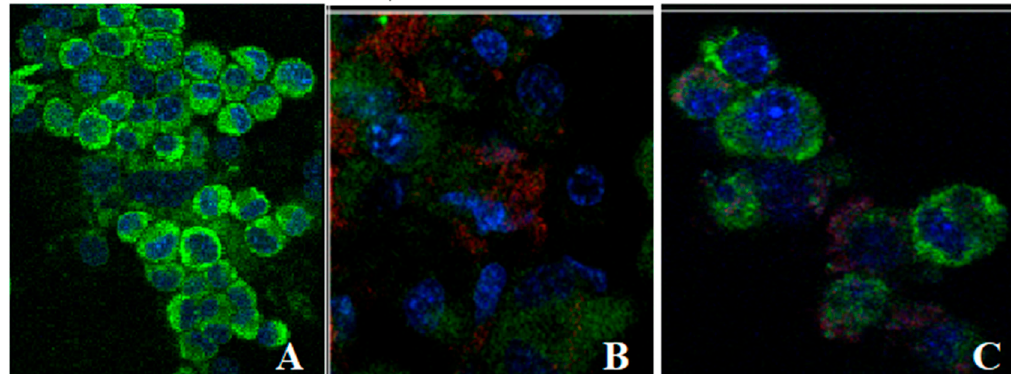
Figure 4. Confocal microscopy images of the uptake of liposomes loaded with L. barbarum by L-929 cells. ( A ) Control without liposomes; ( B ) Cells treated with L1_LB; ( C ) Cells treated with L2_LB; the liposomes are labeled with Rhodamine B(red); cell membrane is stained with WGA-AlexaFluor 488 conjugated (green); cell nuclei are stained with Hoechst (blue).